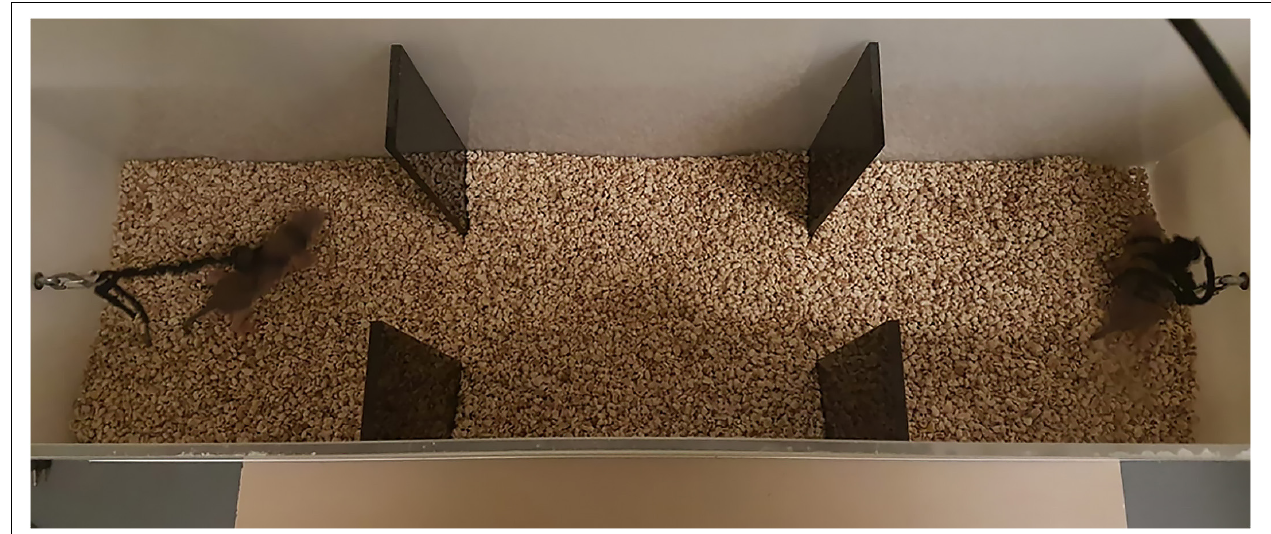
FIGURE 1 | The partner preference test chamber with two tethered stimulus naked mole-rats. One side of the chamber contains the familiar conspecific and the other end contains the unfamiliar conspecific. Tethered animals are blurred in the image because they rarely, if ever, remain